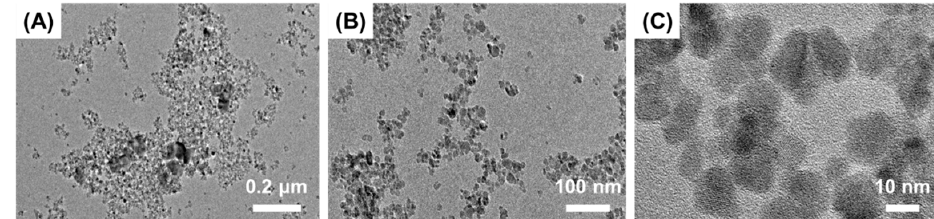
Figure 2. TEM images of Fe 3 O 4 according to measurement magnifications ( A ) 15 k ( B ) 40 k ( C ) 200